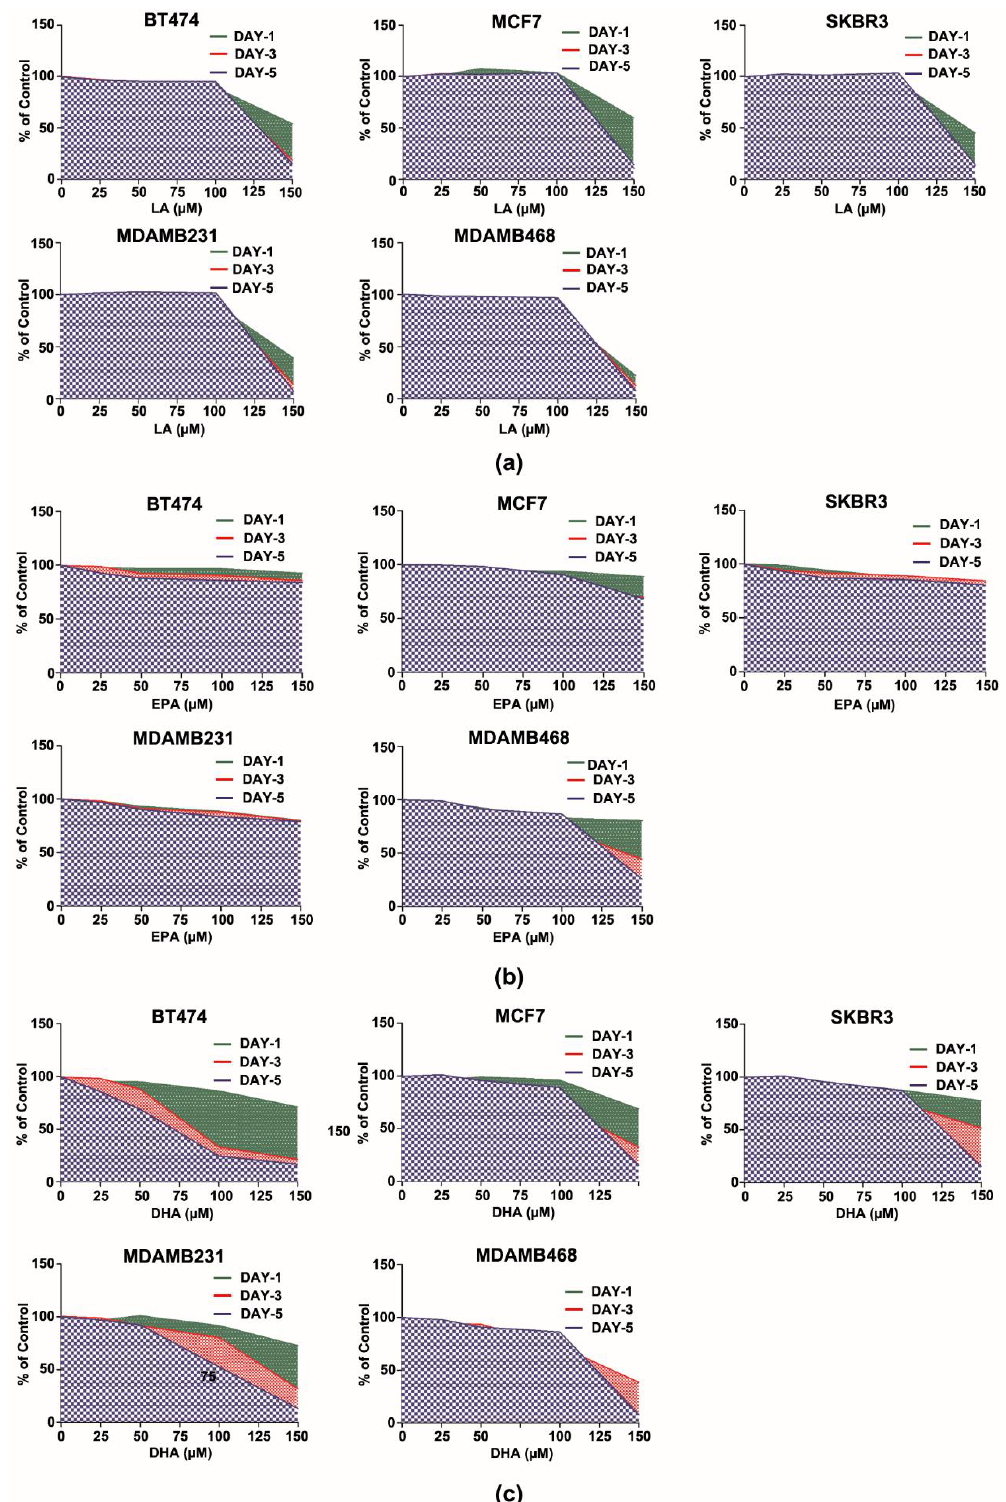
Figure 1. Dose- and time-dependent effects of n6- or n3-fatty acids on the growth of five subtype human breast cancer cells (BT474, MCF7, SKBR3, MDAMB231, and MDAMB468) graphed using the area under the curve (AUC) as a percent of the untreated control. ( a ) Linoleic acid (LA, n6); ( b ) Eicosapentaenoic acid (EPA, n3); ( c ) Docosahexaenoic acid (DHA, n3).